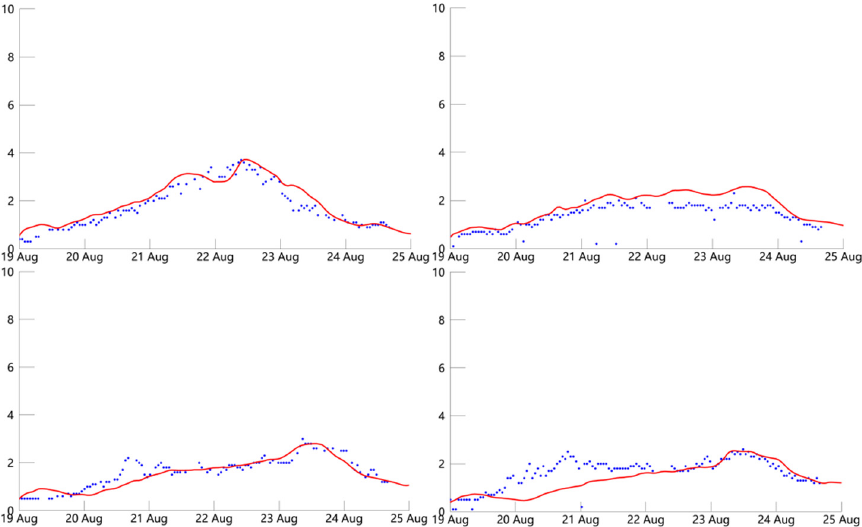
Figure 11. The temporal distributions of significant wave heights (m) obtained from experiment 19 (red line) and buoy observations (blue dot) during typhoon Goni at the locations of four buoys.